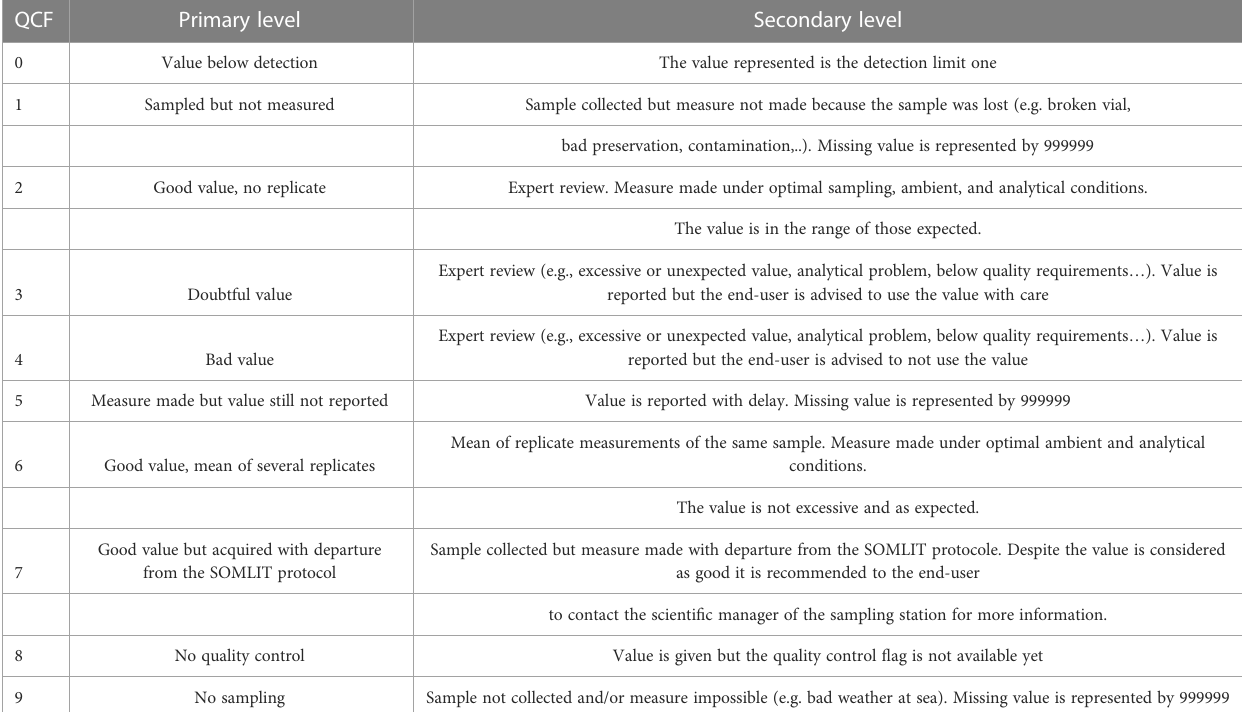
TABLE 2 Primary and secondary level quality control fl ags (QCF) used by the SOMLIT network for the data quali fi cation step.